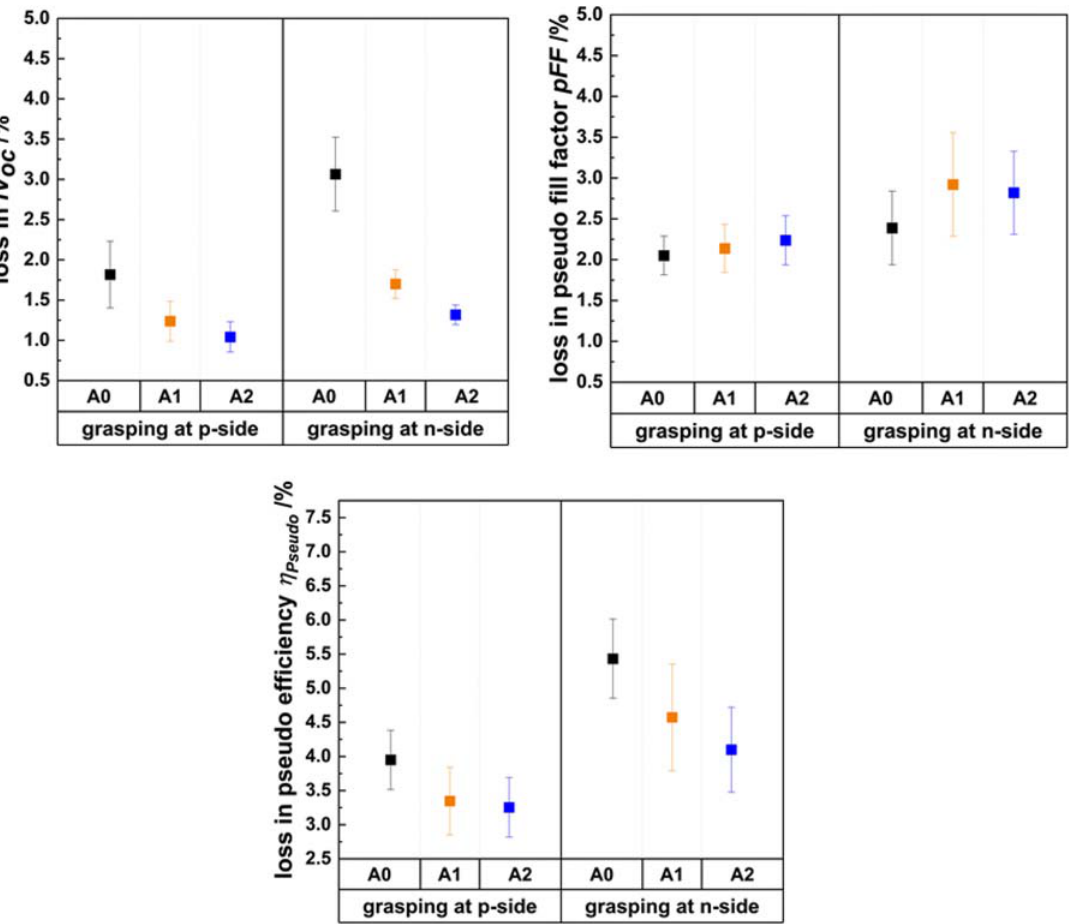
Fig. 8. Graphs showing the local loss analysis for iVoc, pFF, and h pseudo of wafers handled either on the later emitter or non-emitter